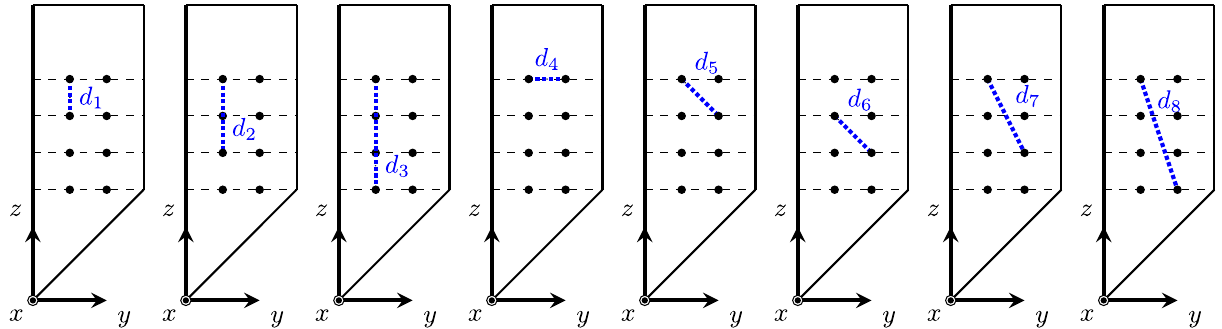
Figure 3. The eight different distances between two same face electrodes. Face [ES] in default side